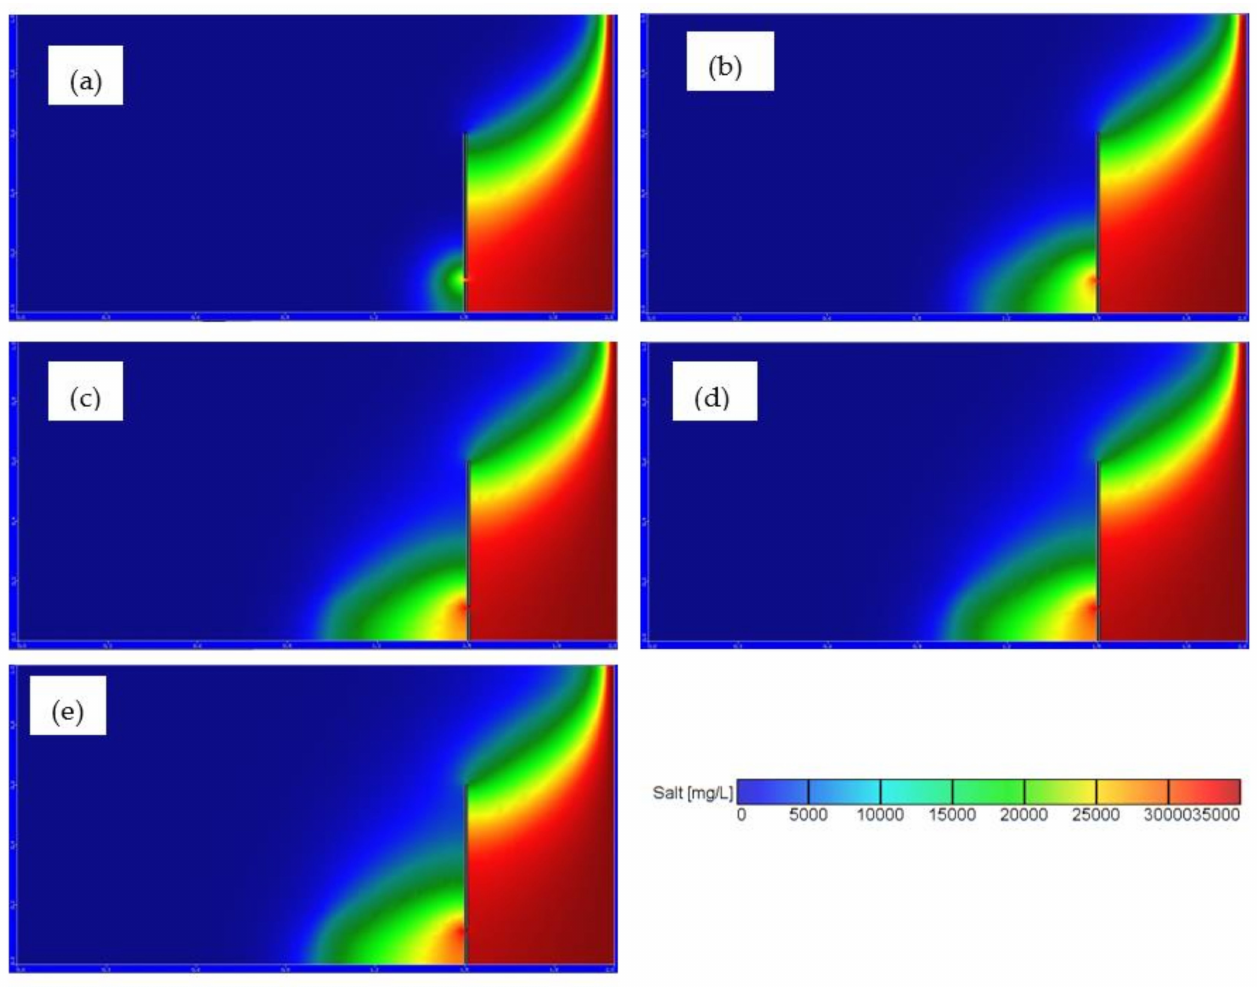
Figure 18. Trasnient seawater intrusion for D f = 0.005 m, H f = 0.1 m, L d = 0.5 m, H w /H d = 0.25, Q w = 5 × 10 − 6 m 3 /s for well location ratio L w /L d = 1.0 at time transient time: ( a ) 5 ( b ) 25, ( c ) 50, ( d ) 75, and ( e ) 100